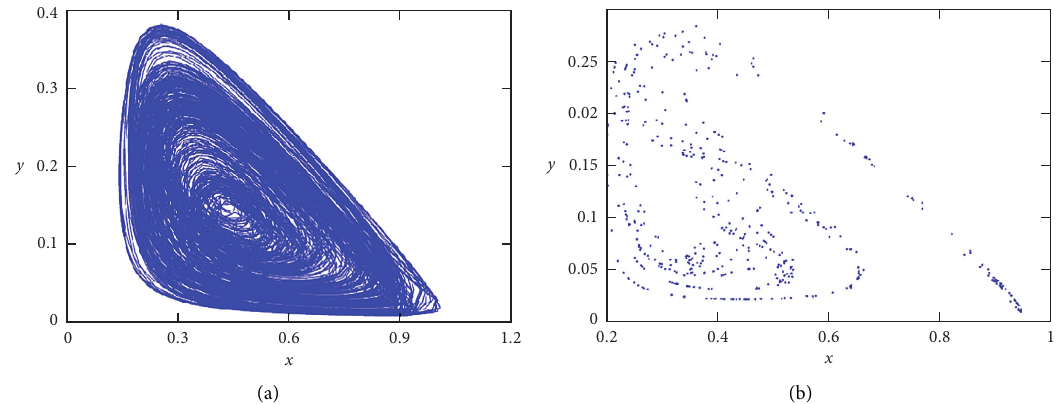
Figure 4: Chaotic phase portrait and its Poincar´e section of nonlinear chemical reaction with parameters of Figure 3 and f � 0.0025.